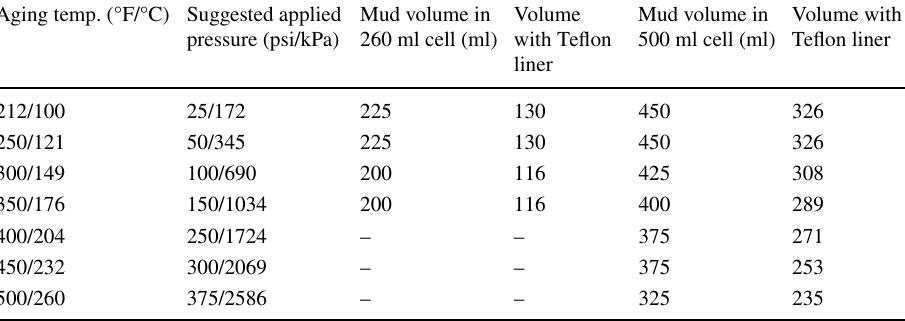
pressure for high-temperature aging (OFI Testing Equipment,